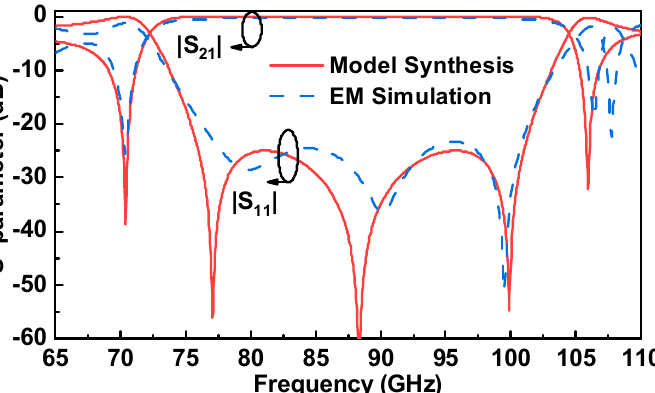
Figure 7. Simulated and measured results of two back-to-back transitions with an (a) LWG length of L 1 and (b) an LWG length of L 2 .